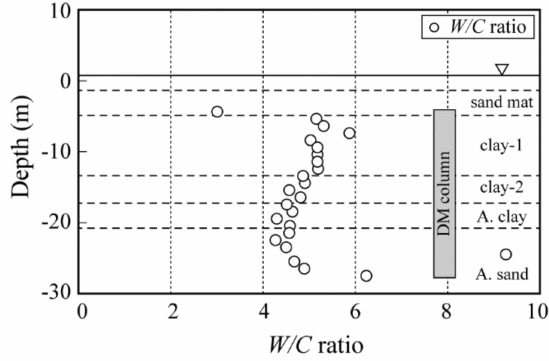
Figure 16. Distribution of W/C ratio along depth.